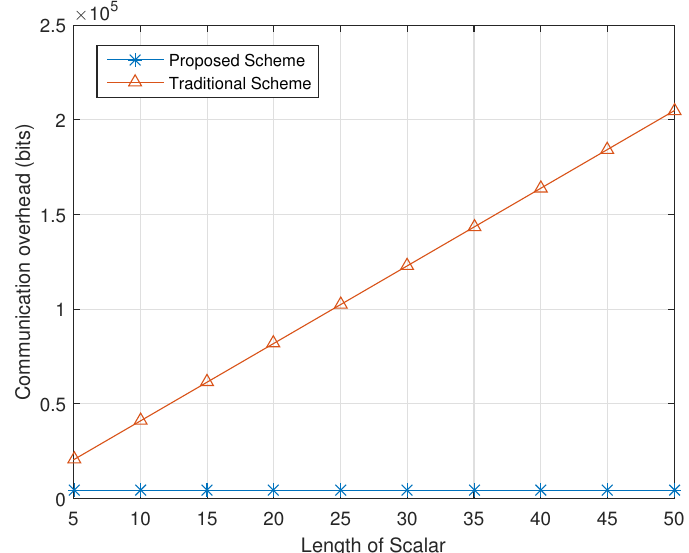
Figure 6. Communication overhead from the data requester to the data